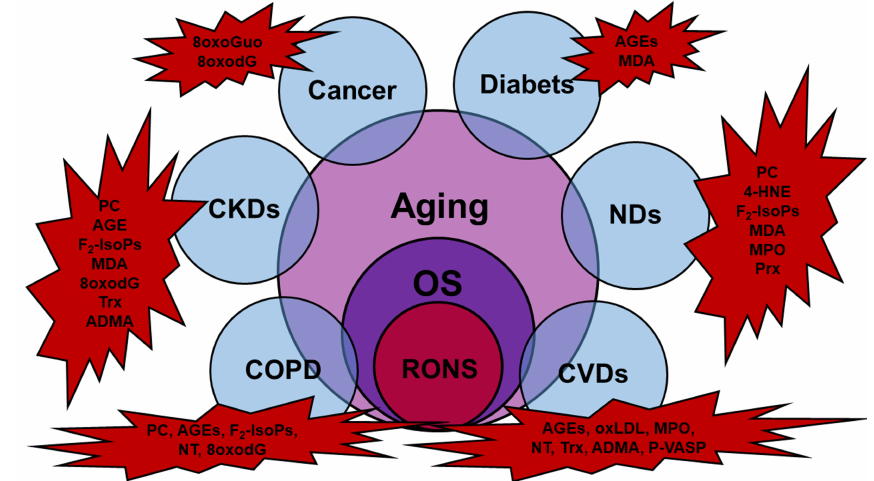
Figure 1. The most reported diseases interconnected to oxidative stress (OS) and to OS-related aging, with evidence of the relative species detected and considered OS biomarkers (red